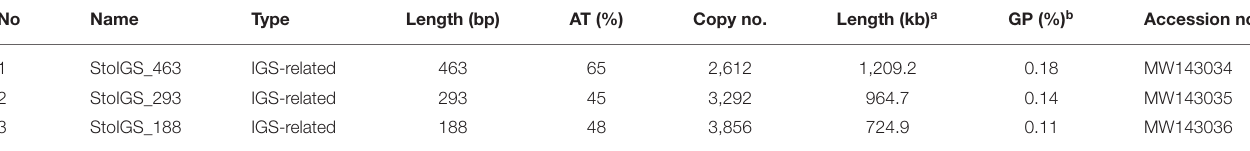
TABLE 2 | Short duplicated sequences identified in the 45S rDNA intergenic spacer using Tandem Repeats